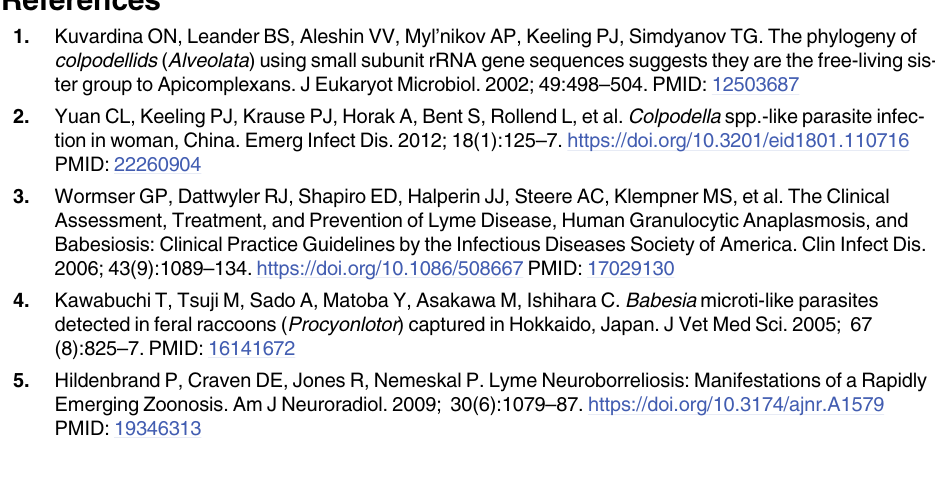
S1 Fig. Timeline of the clinical course of the patient in 2013. S2 Fig. Phylogenetic analysis based on the 18s rRNA gene of Colpodella